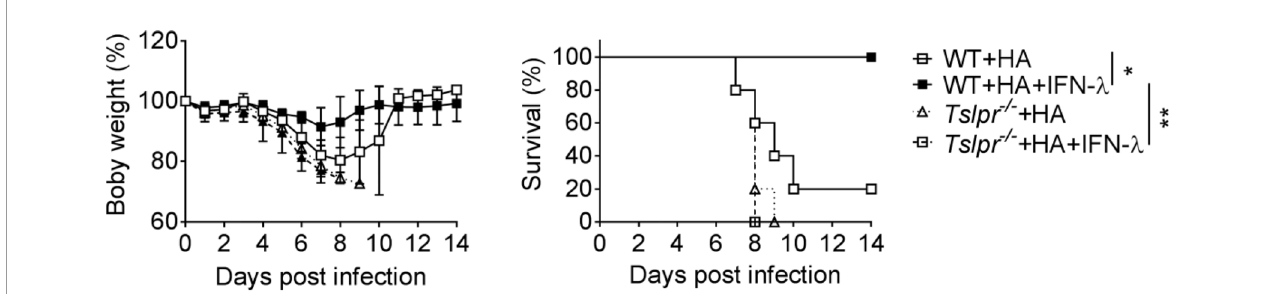
FIGURE 2 | TSLP receptor de fi ciency negatively affects performance of intranasal in fl uenza vaccines. B6-WT (n = 5) and Tslpr – / – (n = 5) mice were intranasally immunized with In fl usplit Tetra ® vaccine (HA) in the presence or absence of 1 m g IFN- l 2. Four weeks after the third booster immunization, mice were infected with